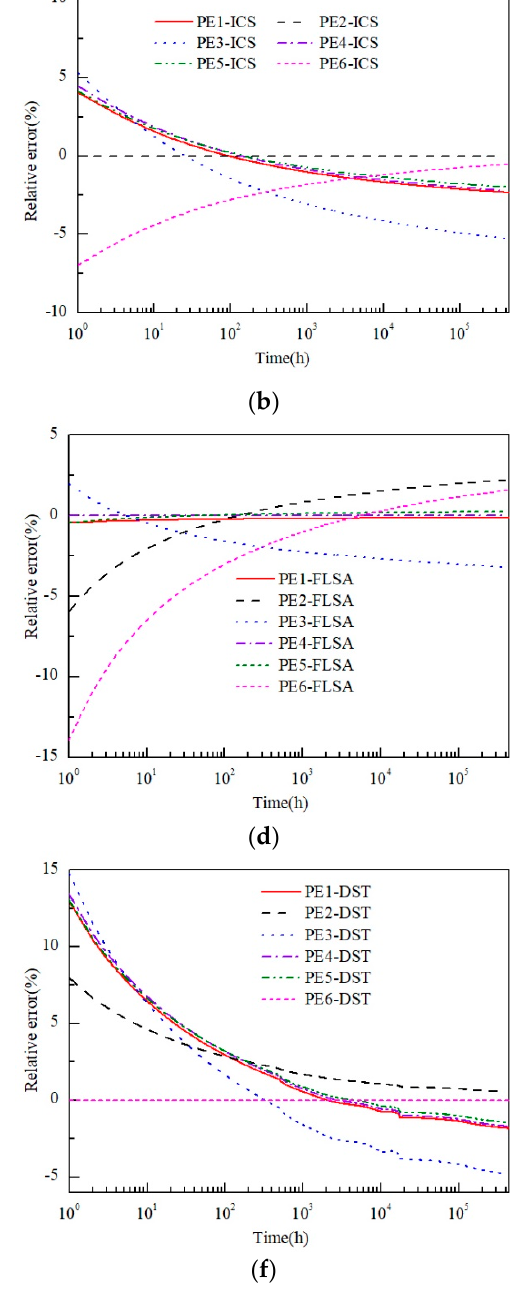
Figure 5. Time evolution of the relative differences caused by using different pairs of estimated parameters. For each subplot, the benchmark case uses the same model both for TRT interpretation and mean fluid simulation. The model used for calculating mean fluid temperature for each subplot is ( a ) ILS; ( b ) ICS; ( c ) FLSN; ( d ) FLSA; ( e ) FLSCC; and ( f ) DST.